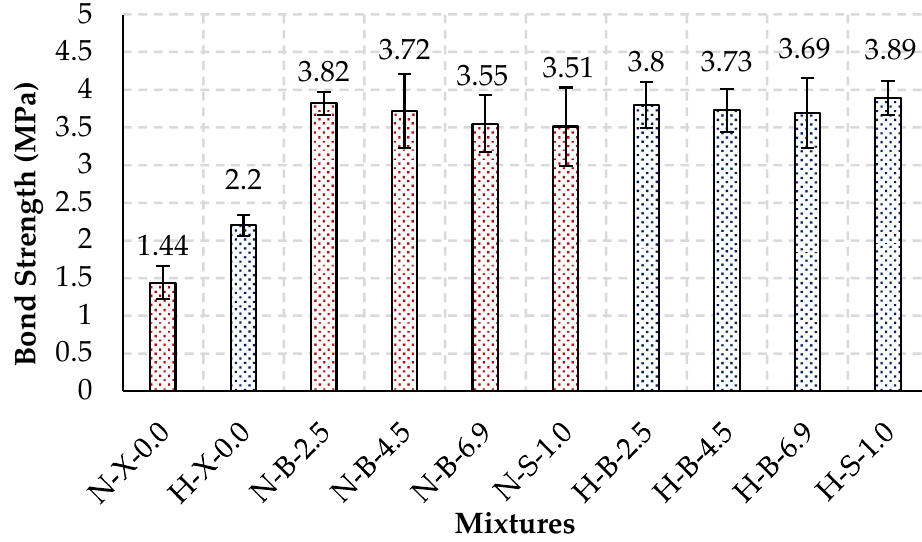
Figure 8. Bond strength of all mixtures from pull-off test.